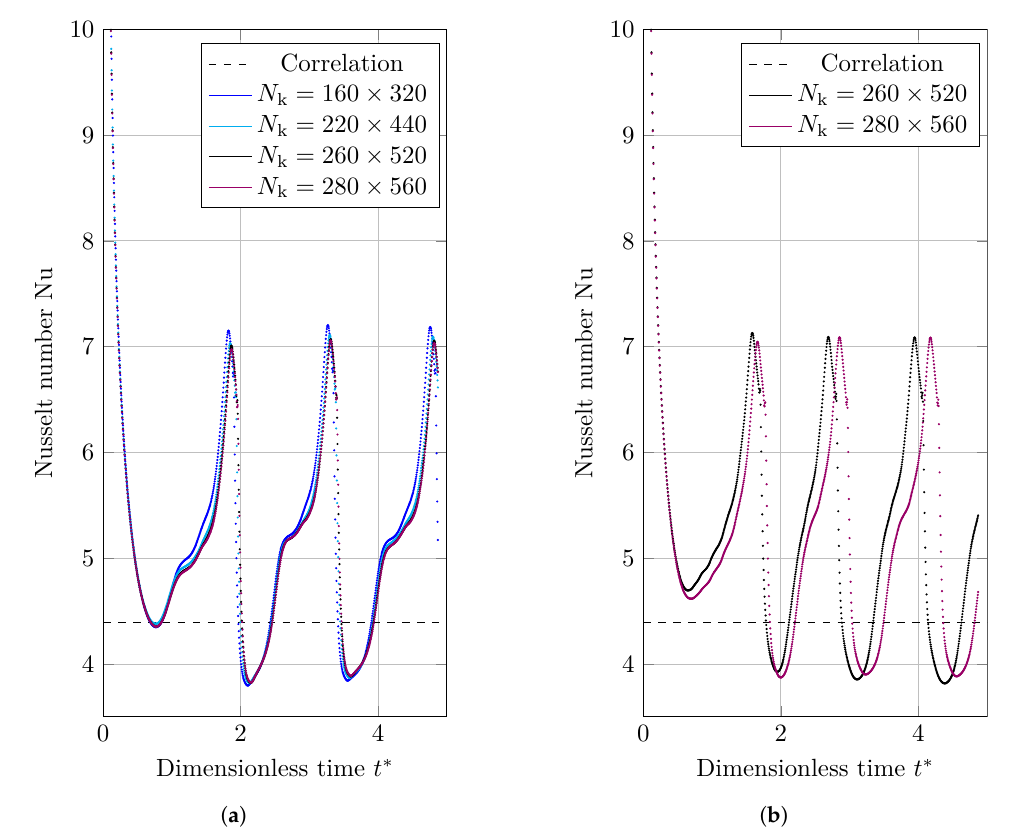
Figure 13. Nusselt number data for the 2D film boiling benchmark scenario that are spatially averaged. The horizontal dashed line is showing the Berenson correlation Nusselt number. ( a ) VOF; ( b ) CLSVOF. In order to perform an individual investigation on the Nusselt number results, the differ- ence between the mean Nusselt number calculated by Berenson correlation (Equation (31)) and time-averaged Nusselt number is presented for VOF and CLSVOF in different studied grid structures (Figure 14). In this case, the error for the time-averaged Nusselt number ( e Nu ) is defined by equation